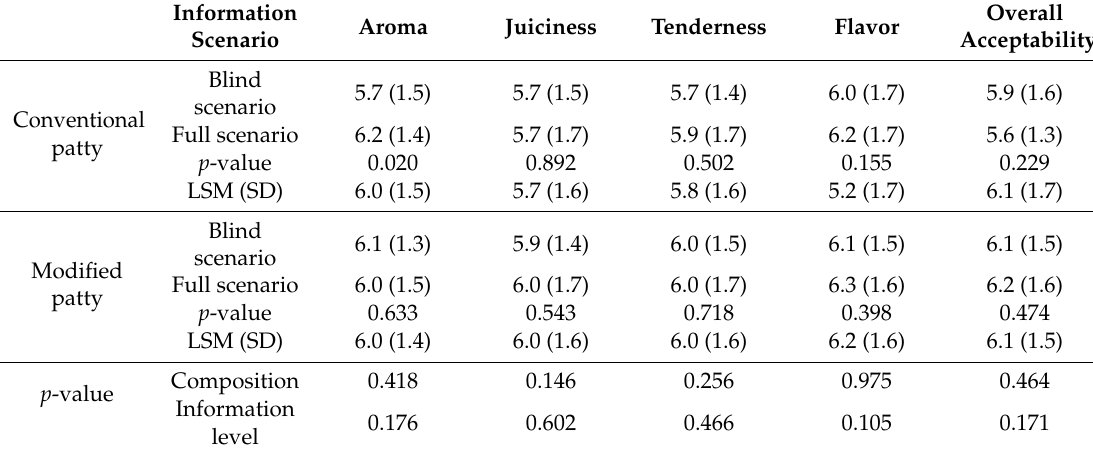
Table 3. Least square means (LSM), standard deviation (SD), and p -values of consumer scores for sensory descriptors of the cooked patties (conventional, and modified with olive and linseed oil mixture and vitamin D 3 ) on the di ff erent information